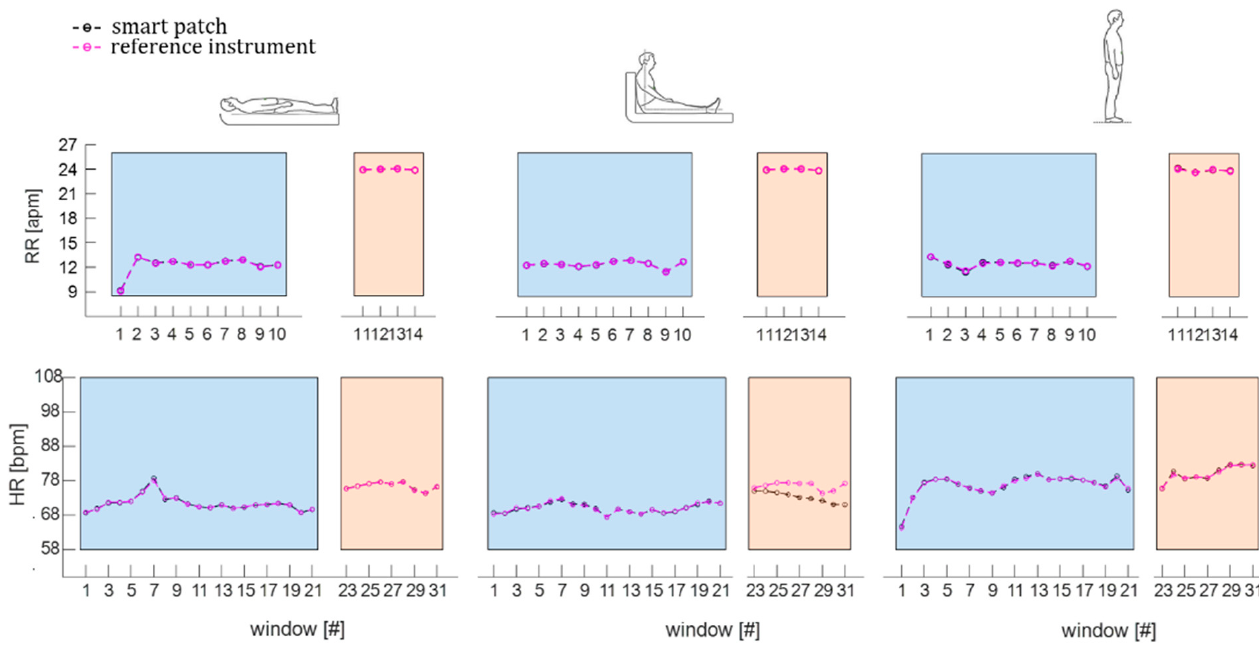
Figure 11. The window-by-window RR values, estimated during eupnea (light blue backgrounds) and tachypnea (light orange backgrounds) in supine, sitting, and standing positions, respectively, and the window-by-window HR values, estimated during eupnea (light blue backgrounds) and tachypnea (light orange backgrounds) in supine, sitting, and standing positions.